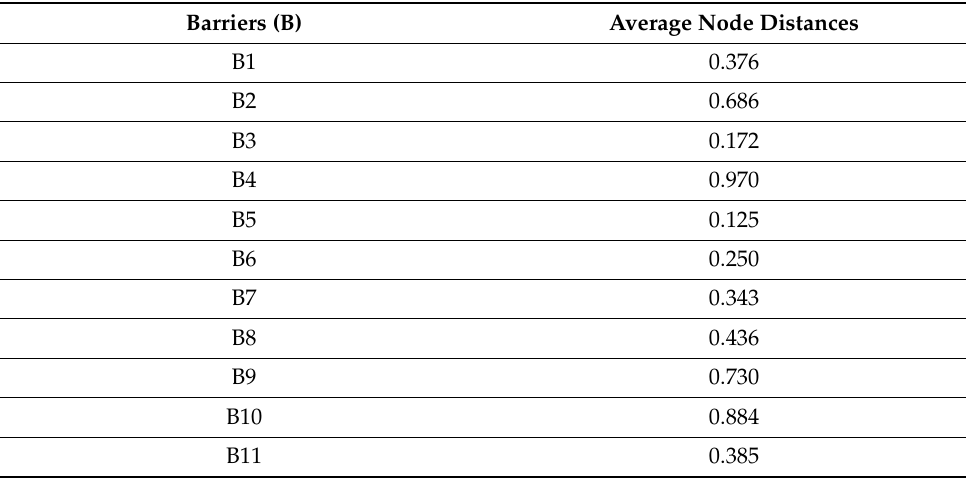
Table 2. The average distance of the nodes between barriers in the open innovation